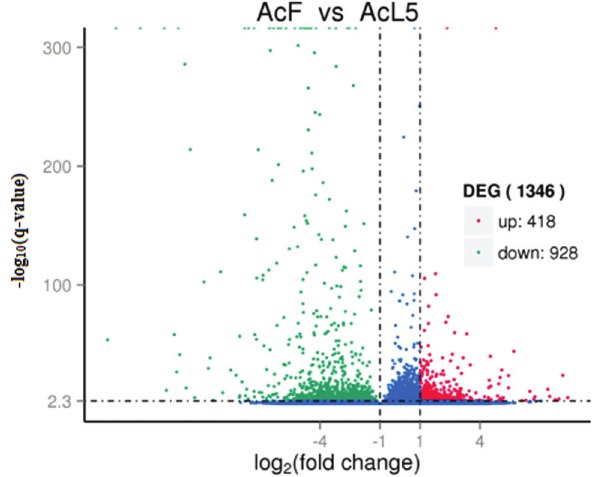
Figure 5 - Volcano plots of differentially expressed genes (DEGs) in L5 andfemaleadults.AcF– A.cantonensis female,AcL5–youngadultsof A. cantonensis . Unigenes that satisfied these conditions (log 2 -fold-change > 1 and q value < 0.005) were considered to be differentially expressed. Blue, red and green splashes represent genes with no significant change in expression, significantly up-regulated genes and significantly down-regulated genes,